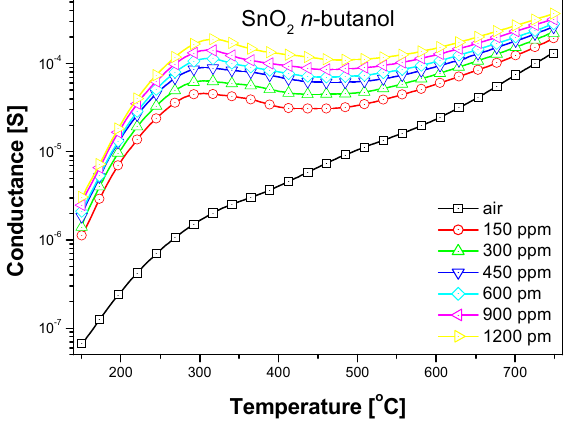
Figure 4. Temperature dependence of sensor conductance in the atmospheres with different concentration of n